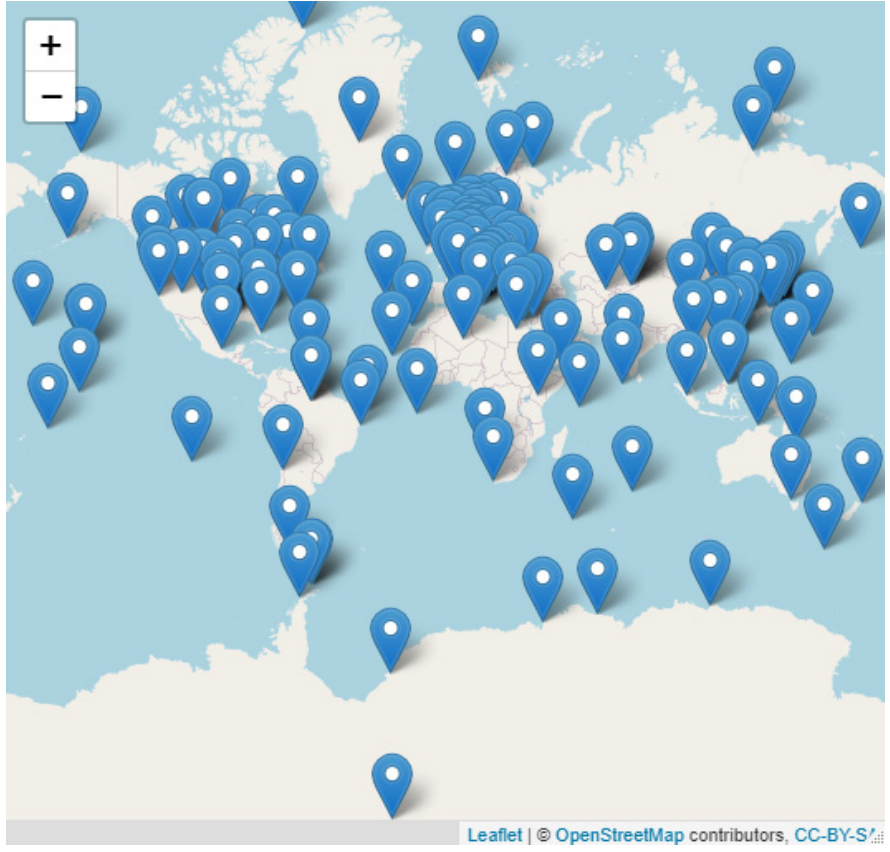
Figure 1. Location of stations considered in the evaluation of re-analysis CO 2 provided by CAMS. The sta-tion name and its description can be accessed at the hypergraph link below (https://rpubs.